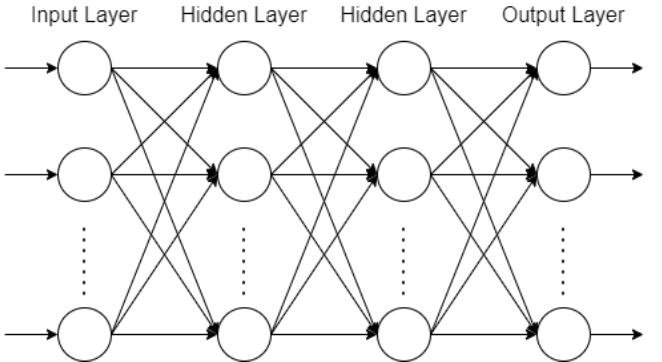
Figure 3. Architectural graph of a MLP with four layers, of which two are hidden between the input and output